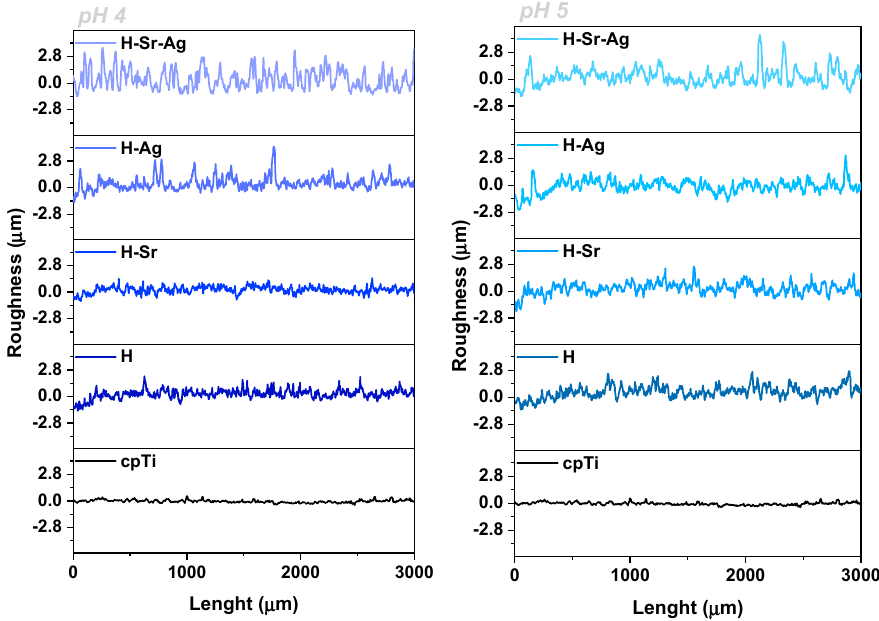
Figure 6. Roughness profiles of the investigated coatings at pH 4 ( left ) and pH 5 ( right ).